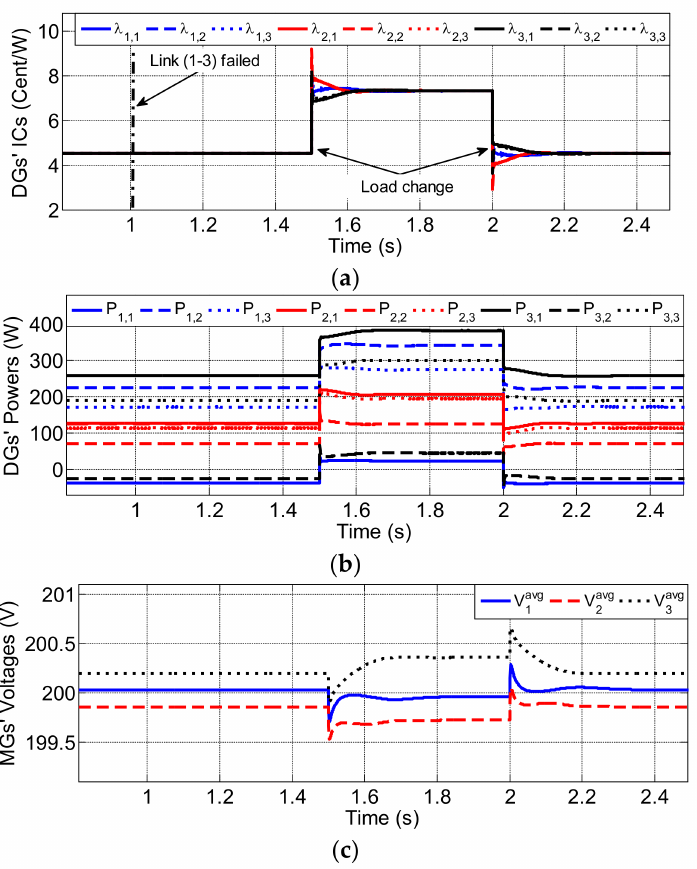
Figure 8. Controller operation with cyber network failures: ( a ) DGs’ incremental costs, ( b ) DGs’ output powers, and ( c ) MGs’ average